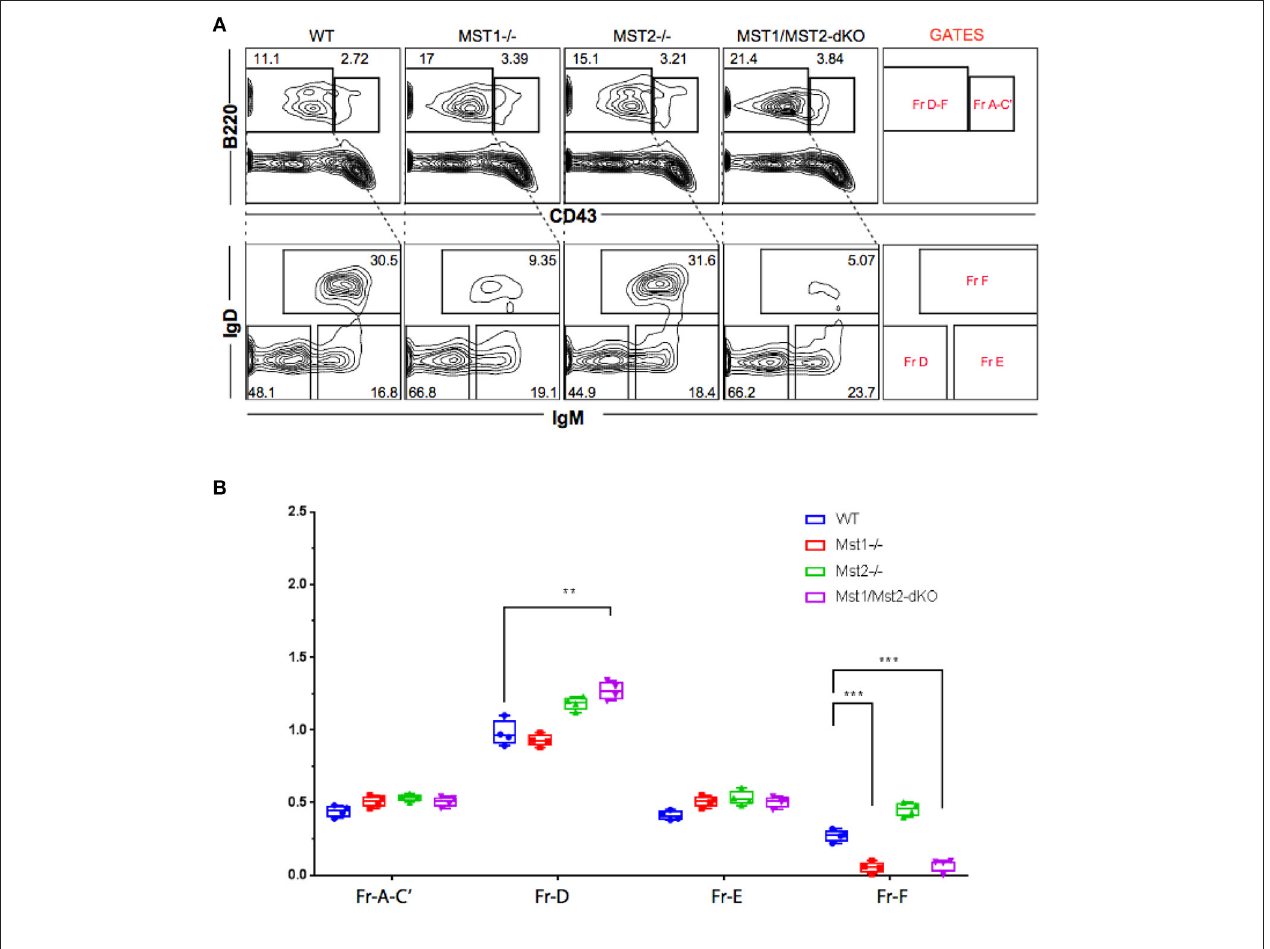
FIGURE 2 | Reduced frequency of perisinusoidal B cells in Mst1 − / − and Mst1/Mst2-dKO mice. (A) Flow cytometric analyses depicting frequencies of different stages of early developing B cells in Bone Marrow of Mst1 − / − , Mst2 − / − , Mst1/Mst2-dKO mice, and WT controls. These flow plots are representative of 5 mice analyzed. The lower panel shows a reduction in the frequency of perisinusoidal B cells (Fraction F) in BM of Mst1 − / − and Mst1/Mst2-dKO. (B) Absolute cell counts of BM B cell fractions in Mst1 − / − , Mst2 − / − , Mst1/Mst2-dKO mice and WT controls. ( n = 5, error bars depict mean ± SD, *** p < 0.001, ** p < 0.05).